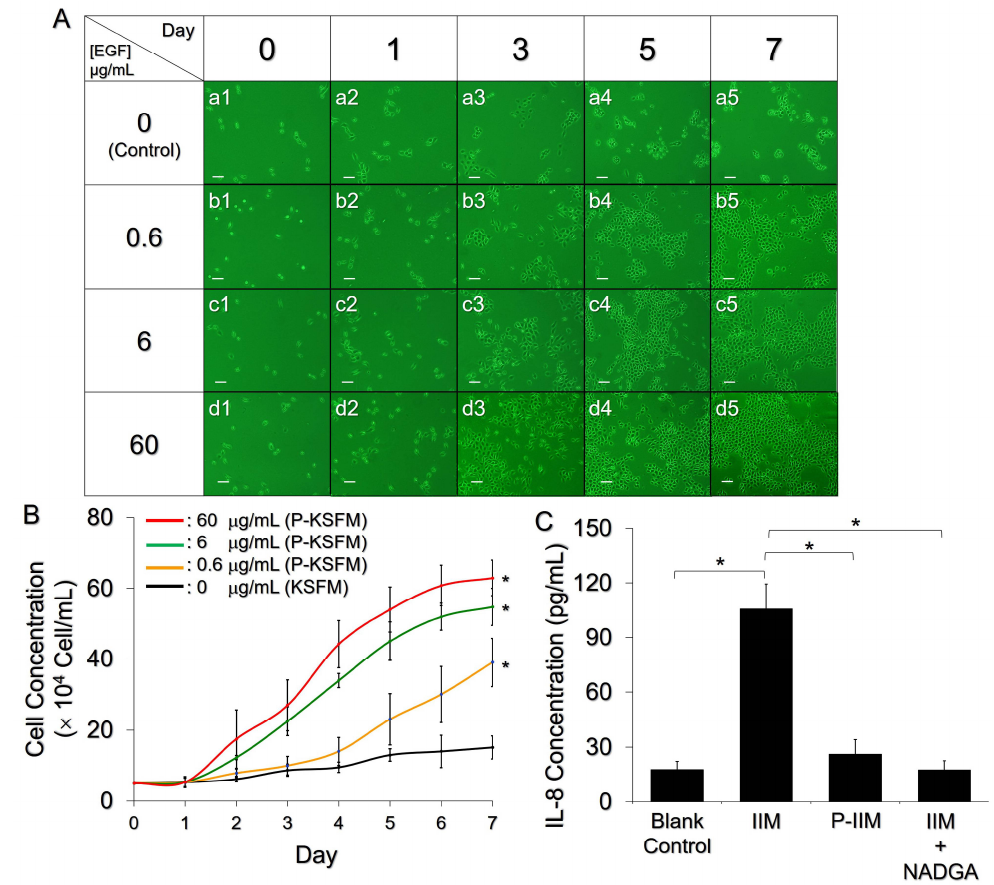
Figure 5. Effects of the P E E NP PCH on cell growth and the inflammatory response. ( A ) Photomicro- graphs of KERTr cells after treatment with P-KSFM for 0, 1, 3, 5, and 7 days, in which the P E E NP PCHs were prepared with 0.6, 6, or 60 µ g/mL EGF. The group cultured with KSFM alone ([EGF] = 0 µ g/mL) was employed as the control. Scale bar = 50 µ m. ( B ) The kinetic profiles of KERTr cell growth after treatment with KSFM or various P-KSFMs within seven days. Values are presented as mean ± s.d. (n = 3). * P < 0.05 compared to the group with KSFM alone. ( C ) IL-8 expression levels in the KERTr